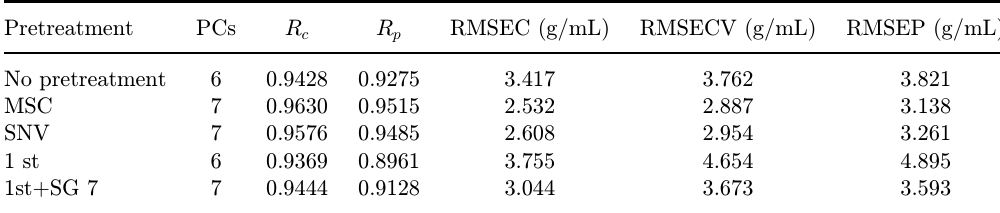
Table 5. Results of di®erent spectral pretreatment methods for quantitative model.